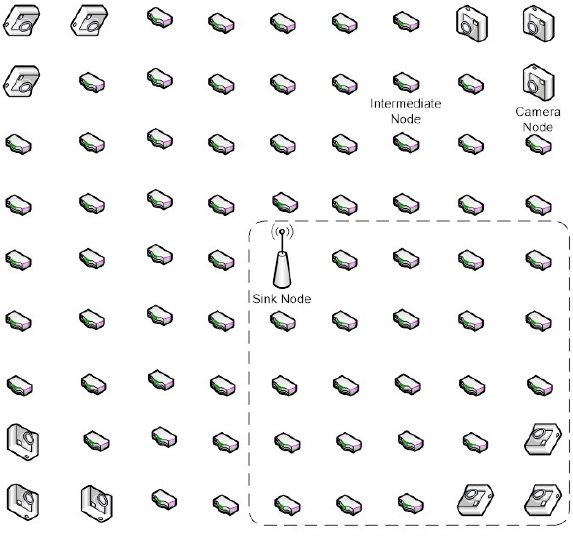
Figure 1. Conventional Visual Sensor Network